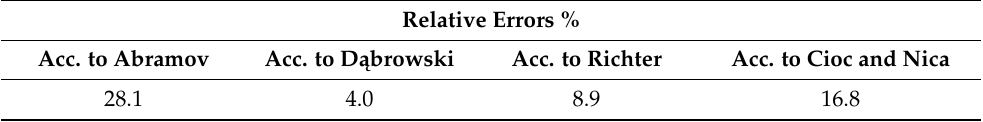
Table 3. Calculation results of the stator leakage reactance of the TWW-200-2A synchronous